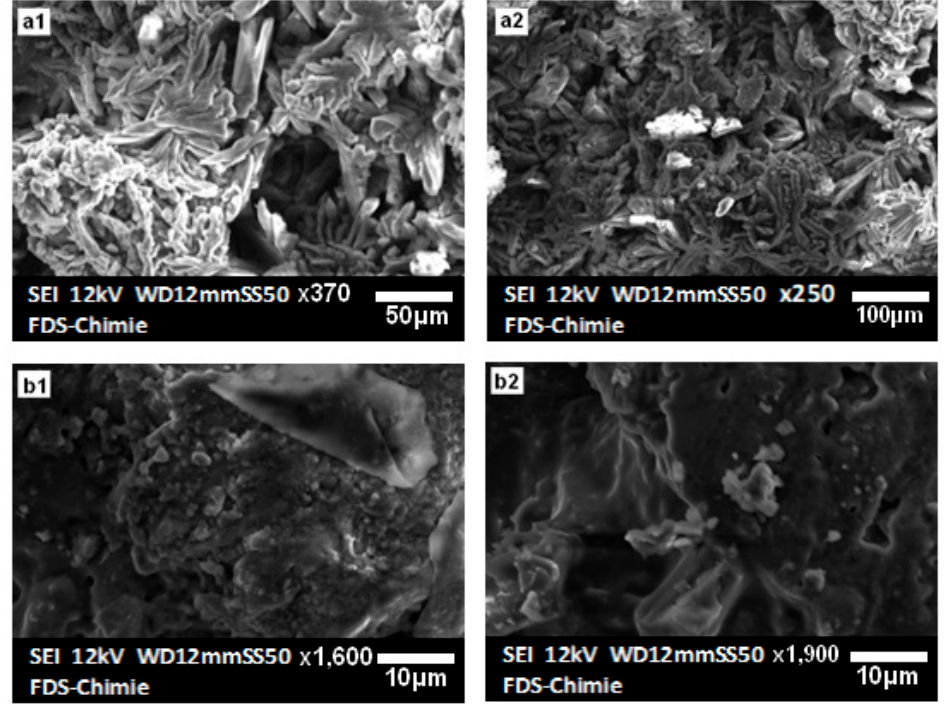
Figure 6. SEM images of zeolite ( a1 , a2 ) and alumina ( b1 , b2 ) cements.